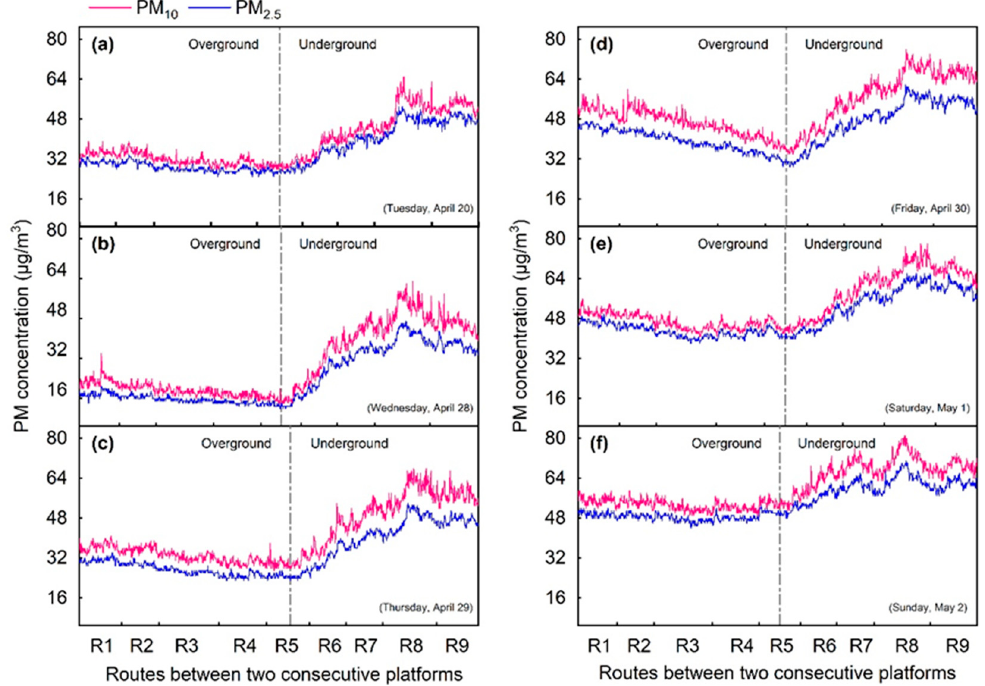
Figure 6. Dynamic PM concentrations in the metro carriage in overground and underground con- ditions on six selected days. ( a ) Tuesday, 20 April. ( b ) Wednesday, 28 April. ( c ) Thursday, 29